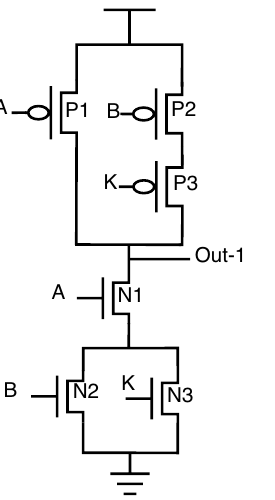
Figure 18. Case-1.